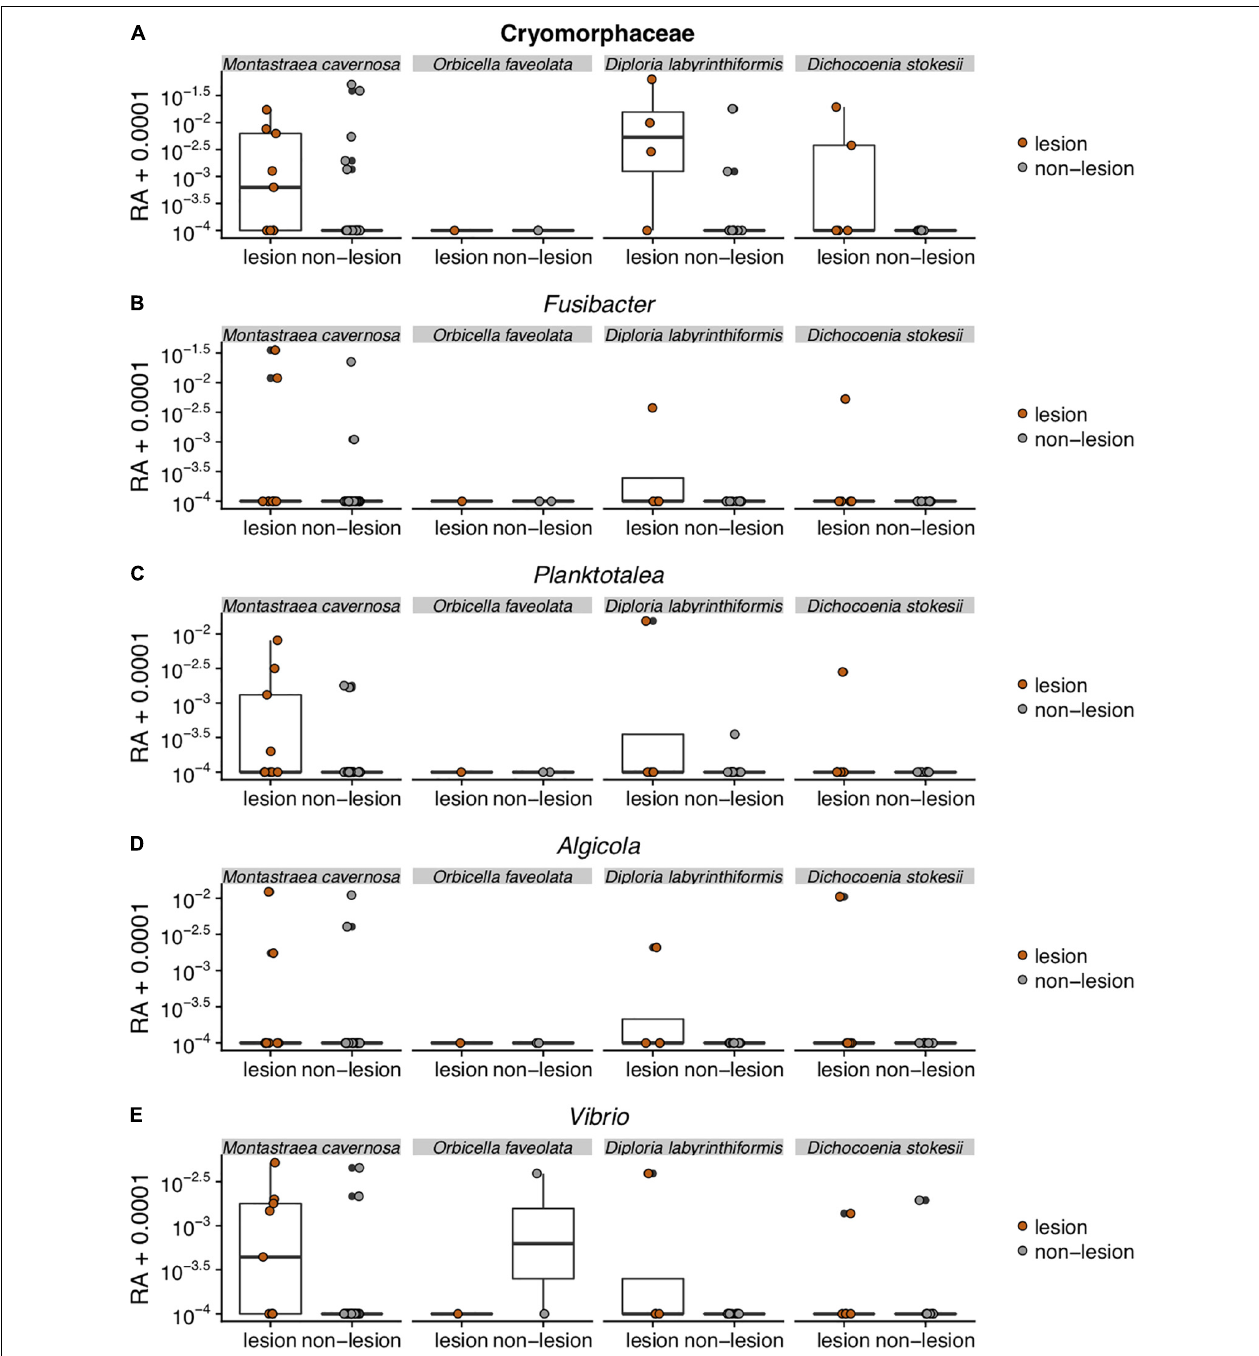
FIGURE 5 | Relative abundance (RA) of the five amplicon sequence variants [Cyromorphaceae (A) , Fusibacter (B) , Planktotalea (C) , Algicola (D) , and Vibrio (E) ] that were differentially abundant in disease lesions versus apparently healthy (non-lesion) tissues of Montastraea cavernosa (Mcav), Orbicella faveolata (Ofav), Diploria labyrinthiformis (Dlab), and Dichocoenia stokesii (Dsto). For display on a logarithmic scale, 0.0001 was added to all values to avoid taking the log of zero.